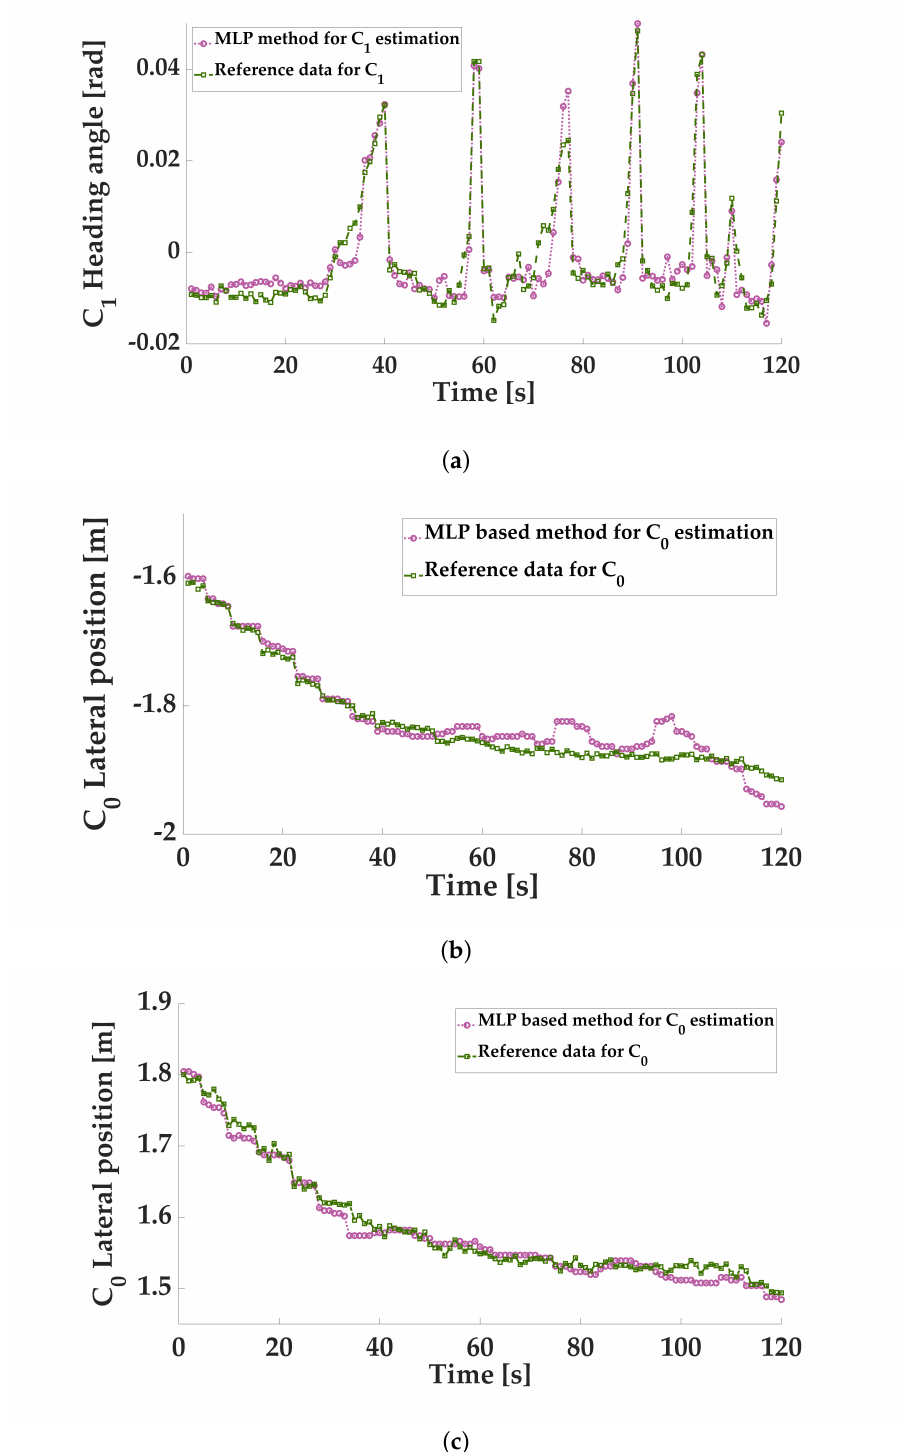
Figure 10. Simulation result for C 0 and C 1 estimation. ( a ) C 1 estimation comparison between camera detection data and MLP based output. ( b ) C 0 of left lane estimation comparison between camera detection data and MLP based output. ( c ) C 0 of right lane estimation comparison between camera detection data and MLP-based